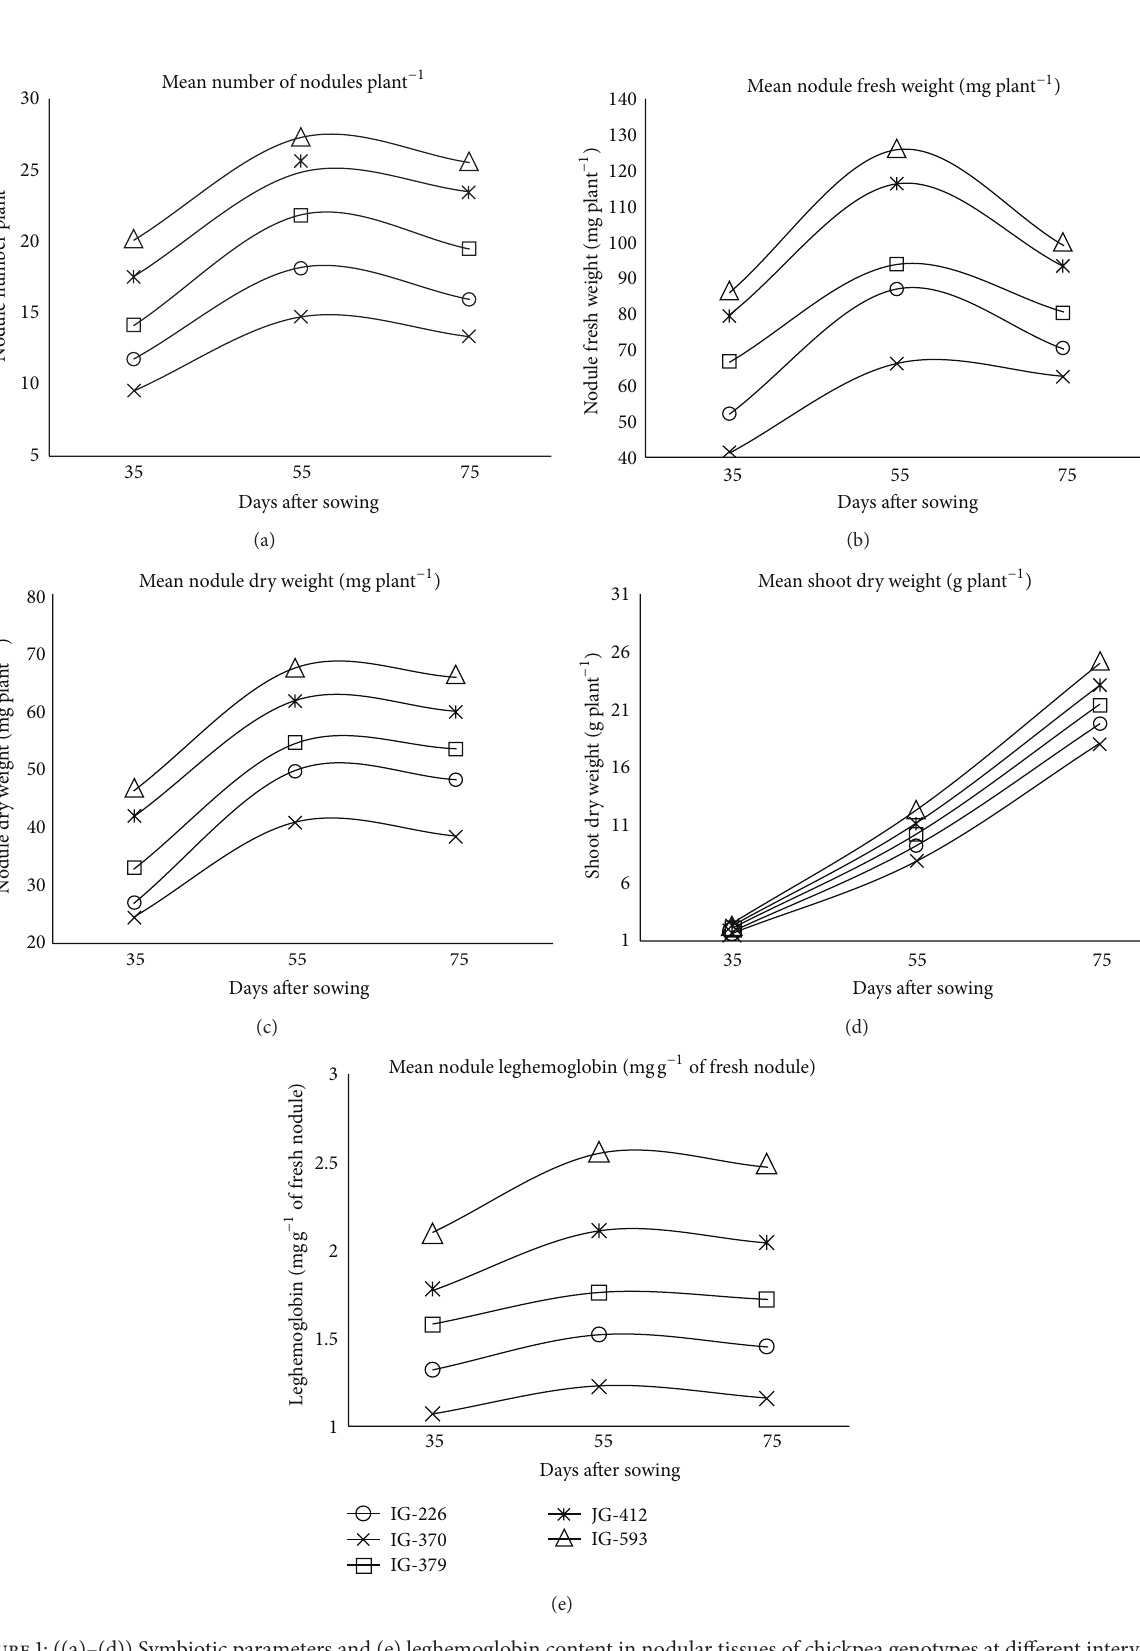
Figure 1: ((a)–(d)) Symbiotic parameters and (e) leghemoglobin content in nodular tissues of chickpea genotypes at different